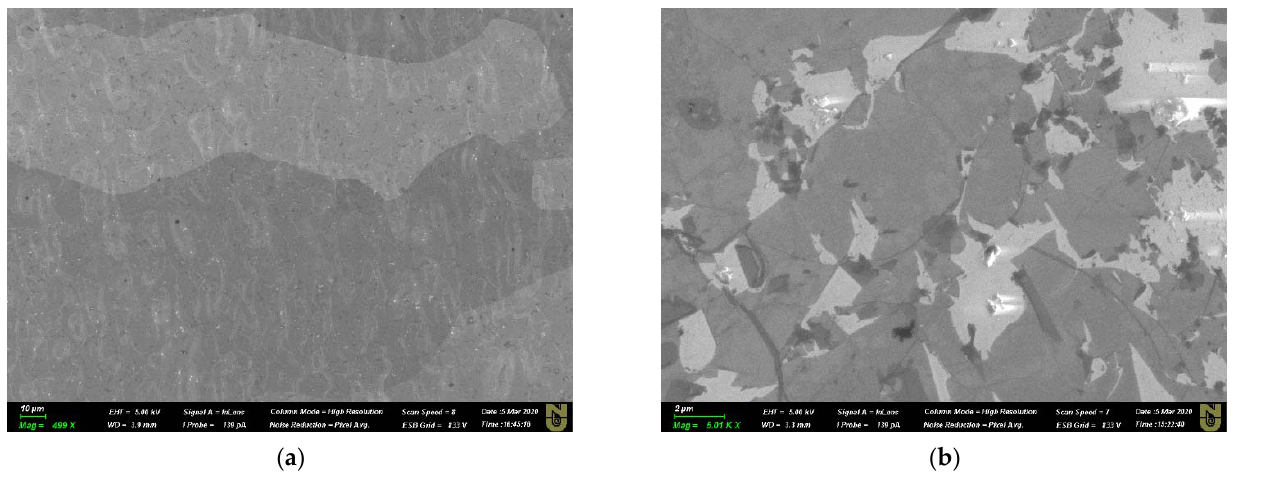
Figure 1. Low ‐ temperature chamber: General view of the admittance measurement chamber: 1— microcryogenic machine body; 2—cell cover; 3—electrical contacts; 4—viewing window; 5—test sample; 6—mica insulator; 7—substrate.